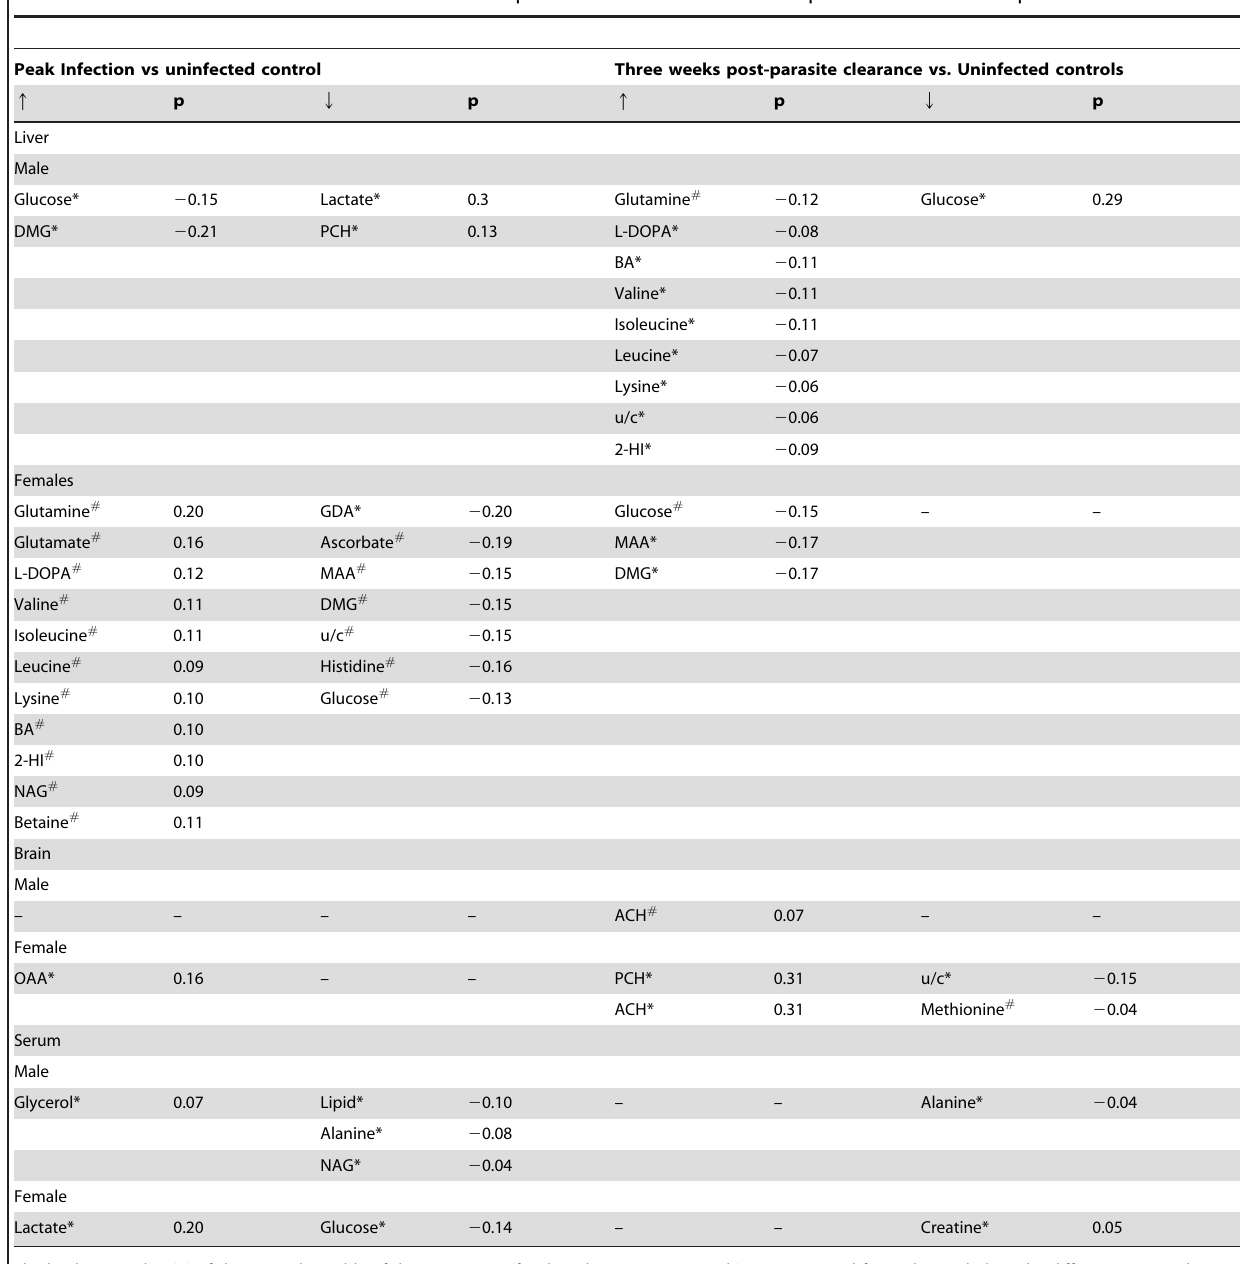
Table 2. Metabolites significantly contributing to the separation of liver, brain and serum 1 H NMR profiles of uninfected control Balb/C mice from mice infected with P. chabaudi at peak infection or three weeks post-clearance of the parasite.